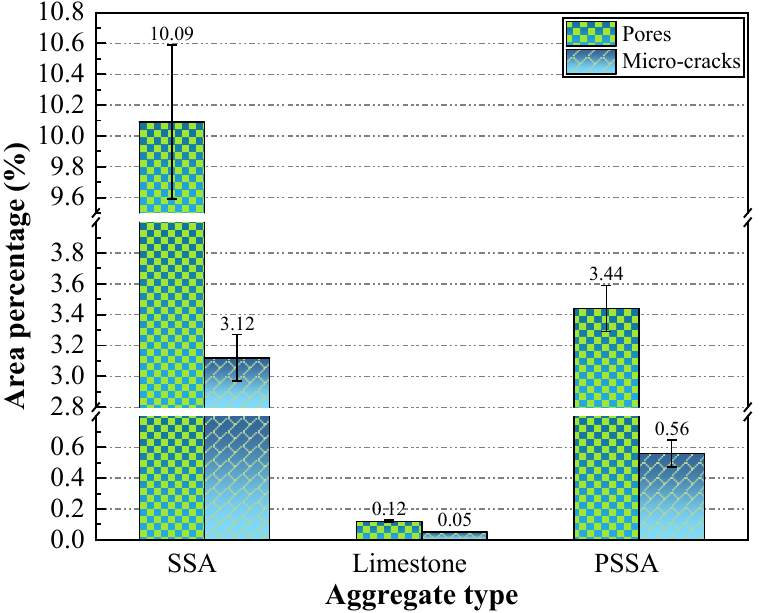
Figure 6. >The pores and micro-cracks area percentage of SSA and PSSA. Figure 6. The pores and micro-cracks area percentage of SSA and PSSA.